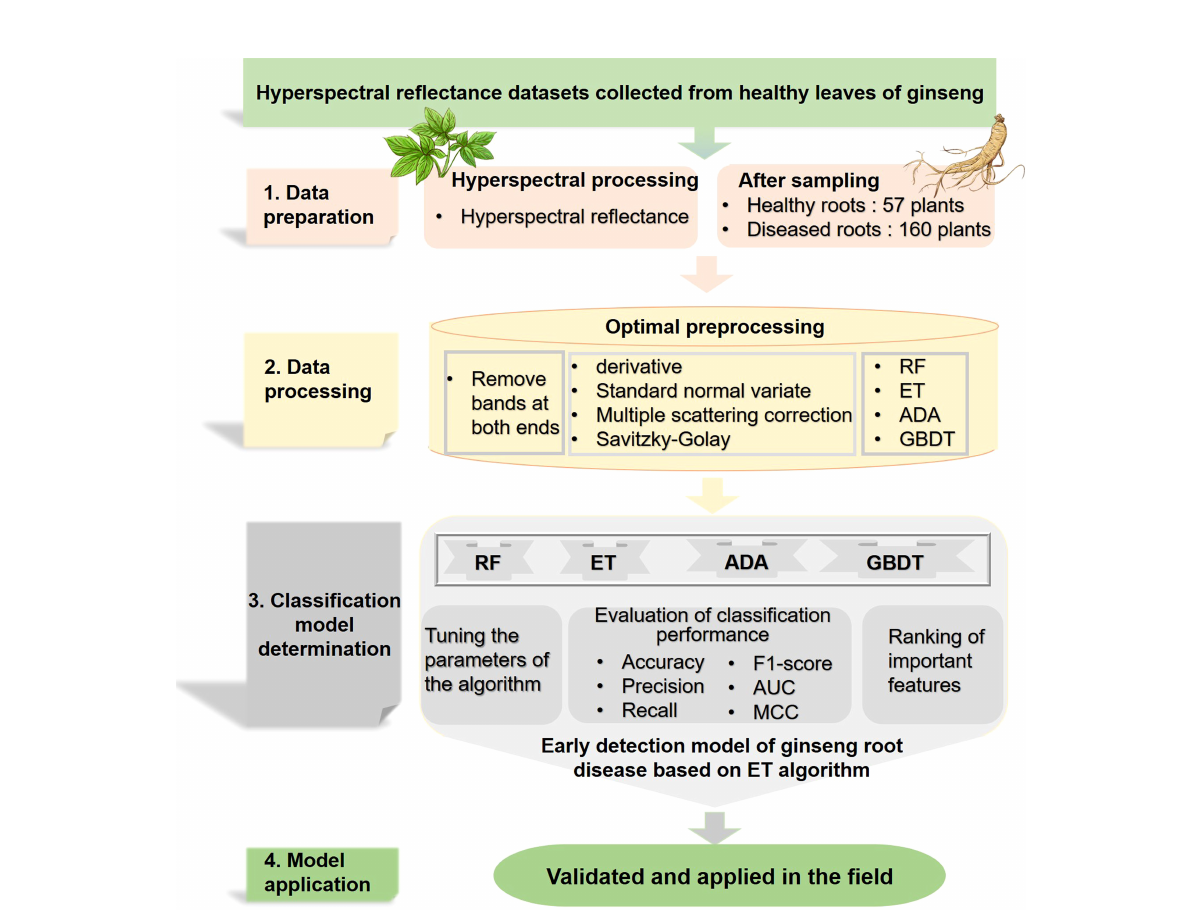
FIGURE 8 Schematic diagram of the classi fi cation method based on the ET algorithm for spectral detection of ginseng root diseases. same as Figure 6; AUC, area under the curve; MCC, Matthew ’ s correlation coef fi